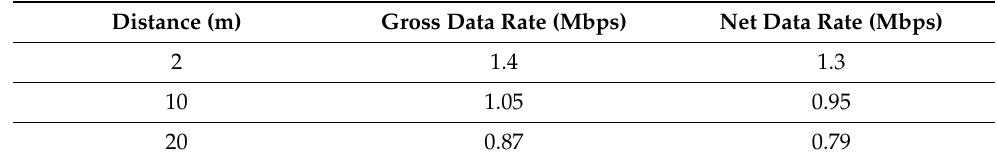
Table 2. Performance at different propagation